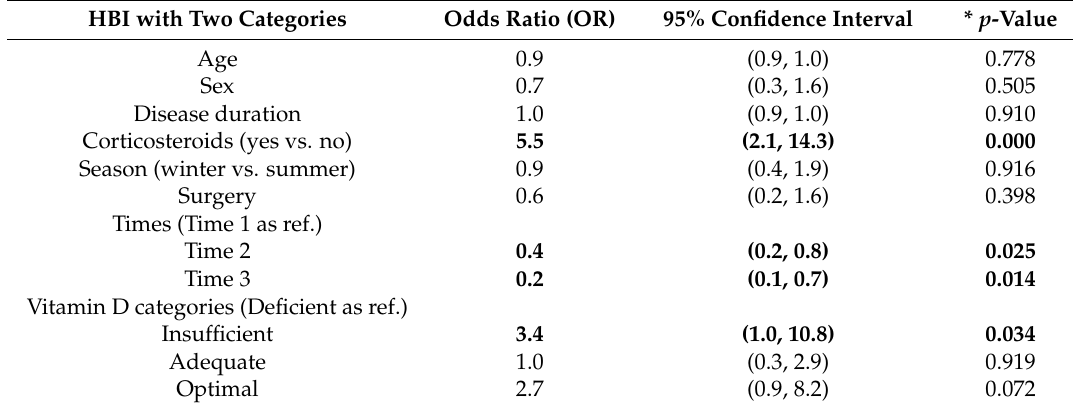
Table 5. Factors Associated with HBI Scores among Crohn’s Disease